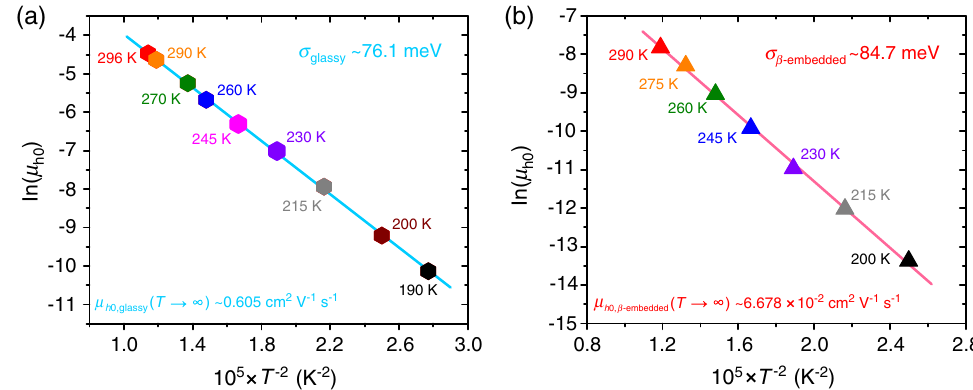
FIG. 21. Analysis of temperature-dependent HMW PFO TOF hole mobility data based on the GDM. The plots show zero-field hole mobility μ versus T − 2 for the estimation of energetic disorder breadth σ and high-temperature-limit μ h 0 experimental TOF μ data as in Fig. 2(b): (a) for the glassy device and (b) for the β -phase embedded h